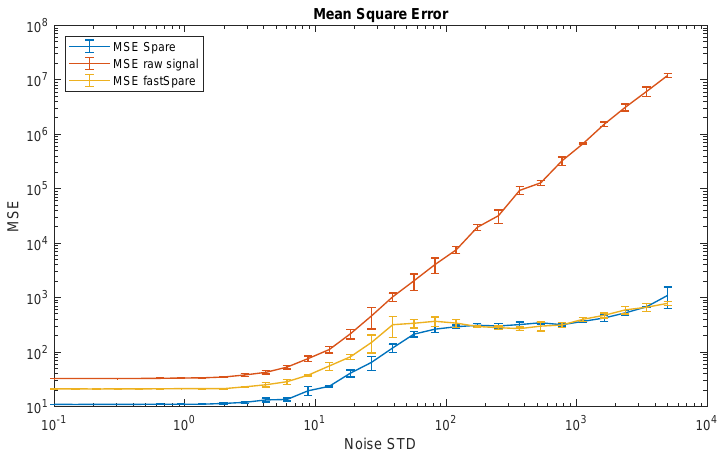
Figure 10. Mean square error (MSE) between the original PPG signal and the reconstructed one by SPARE and fastSPARE at different noise levels. For comparison, the MSE between the PPG signal without SPARE and the reference is also reported (orange